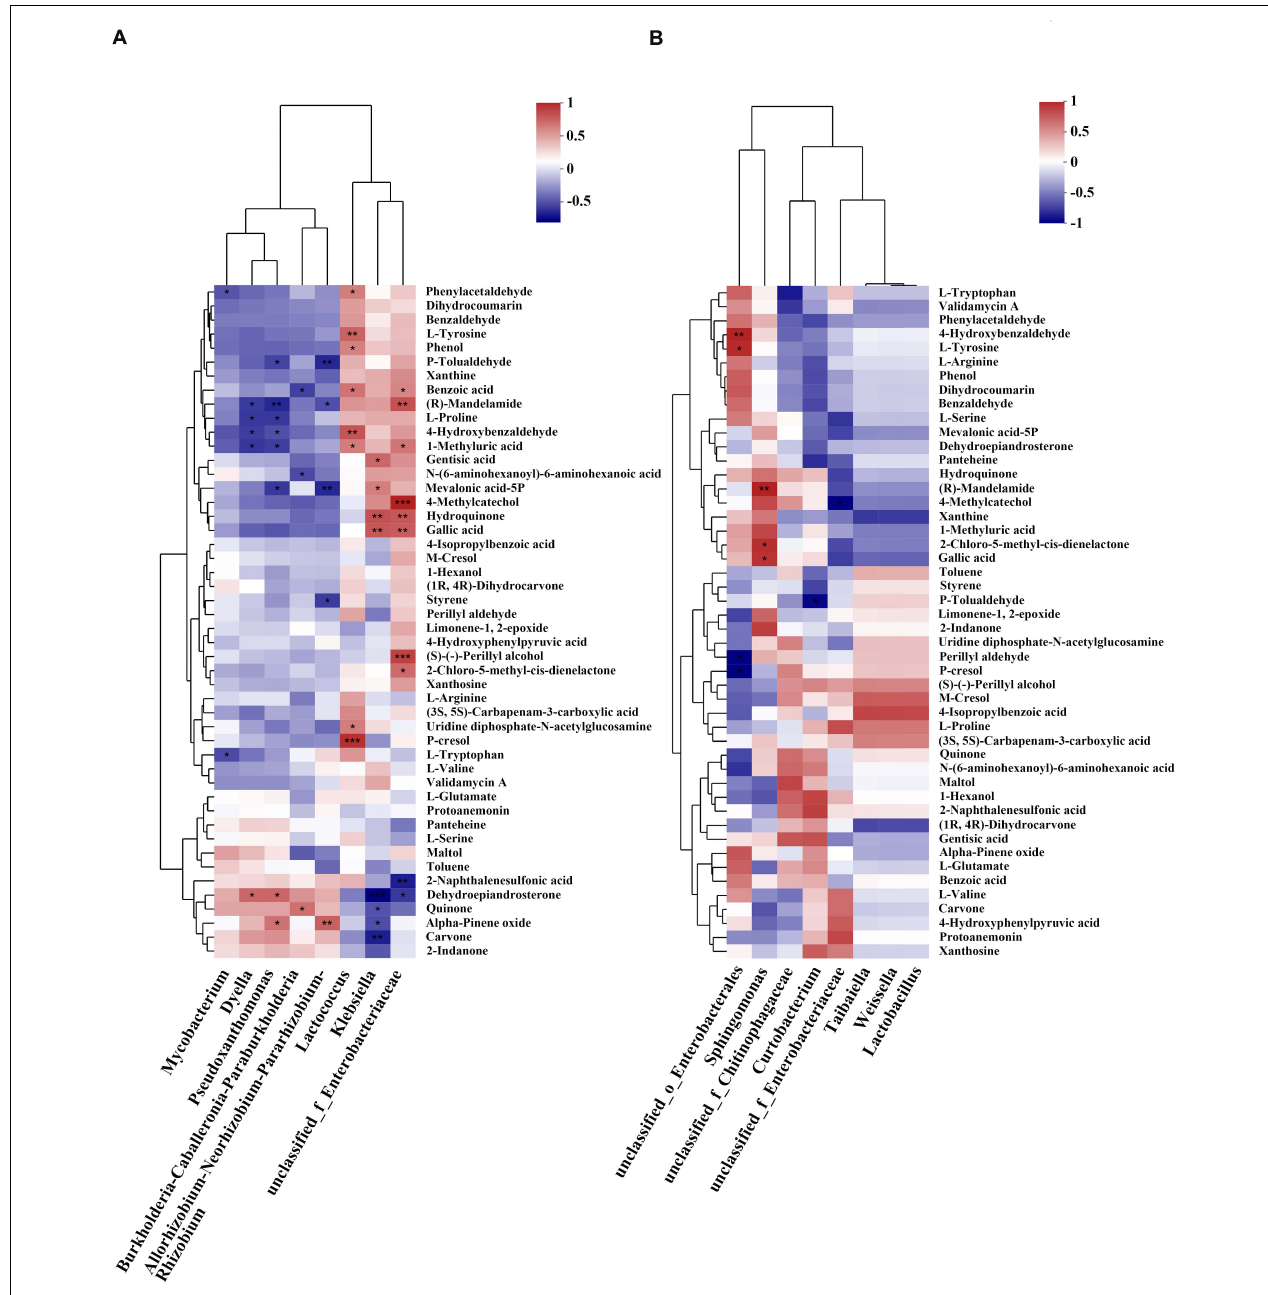
FIGURE 8 | Correlation analysis between genera abundant in the gut and gut metabolite contents annotated as putative plant defense substances. (A) Correlations between the top five abundant genera in larvae feeding on all host tree species and compounds annotated as related to plant defense substances. (B) Correlations between abundant genera in P. tabuliformis feeders (abundance ≥ 2%, except for the top five) and putative plant defense metabolites. Each row in the figure represents a metabolite, each column represents a genus, and each lattice represents a Pearson correlation coefficient between a component and a metabolite. Red represents positive correlations, while blue represents negative correlations (* P < 0.05, ** P < 0.01, *** P <